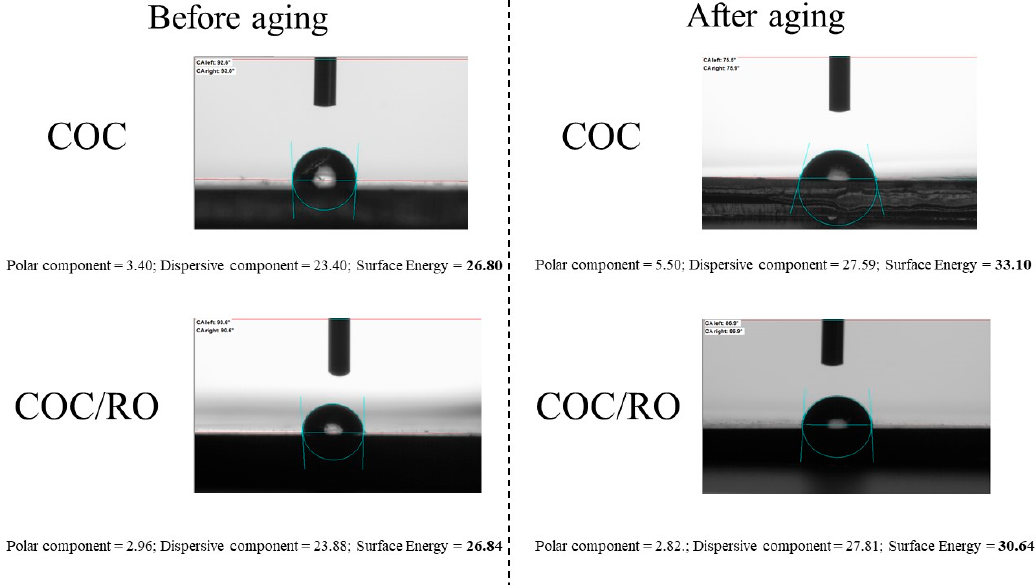
Figure 8. Surface energy of neat COC composite and COC filled with red ochre before and after 500 h of irradiation (images show the contact angle for water).